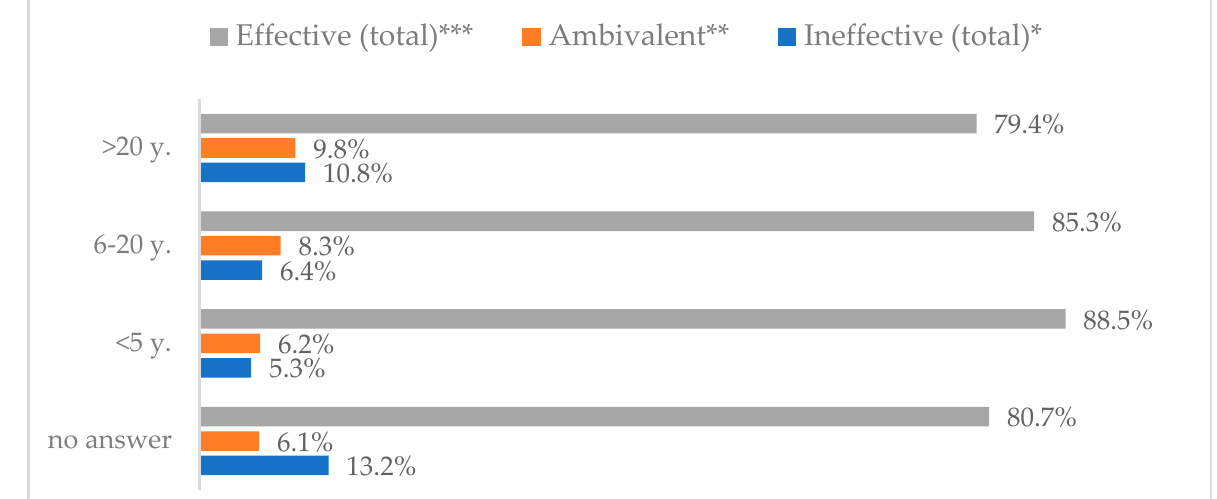
Figure 10. Hand washing to prevent influenza virus infection by seniority ( N = 905). *Sum of responses: completely ineffective, ineffective, rather ineffective; **Response: neither ineffective nor effective; **Sum of responses: rather effective, effective, completely effective.